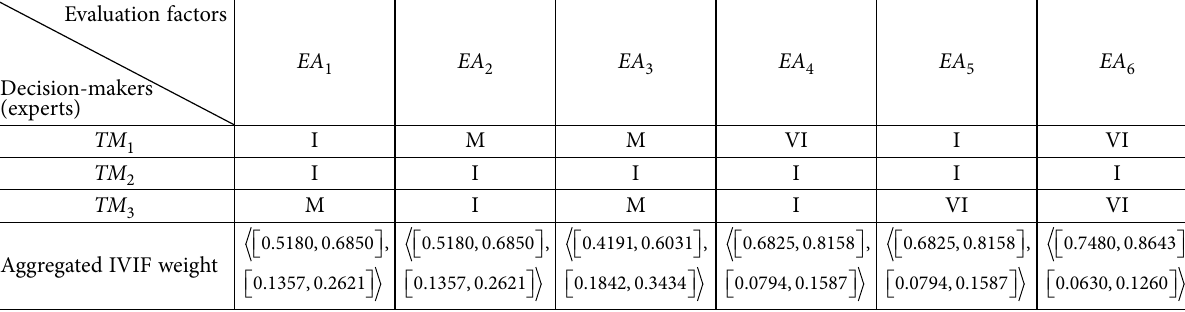
Table 4. IVIF importance of evaluation factors